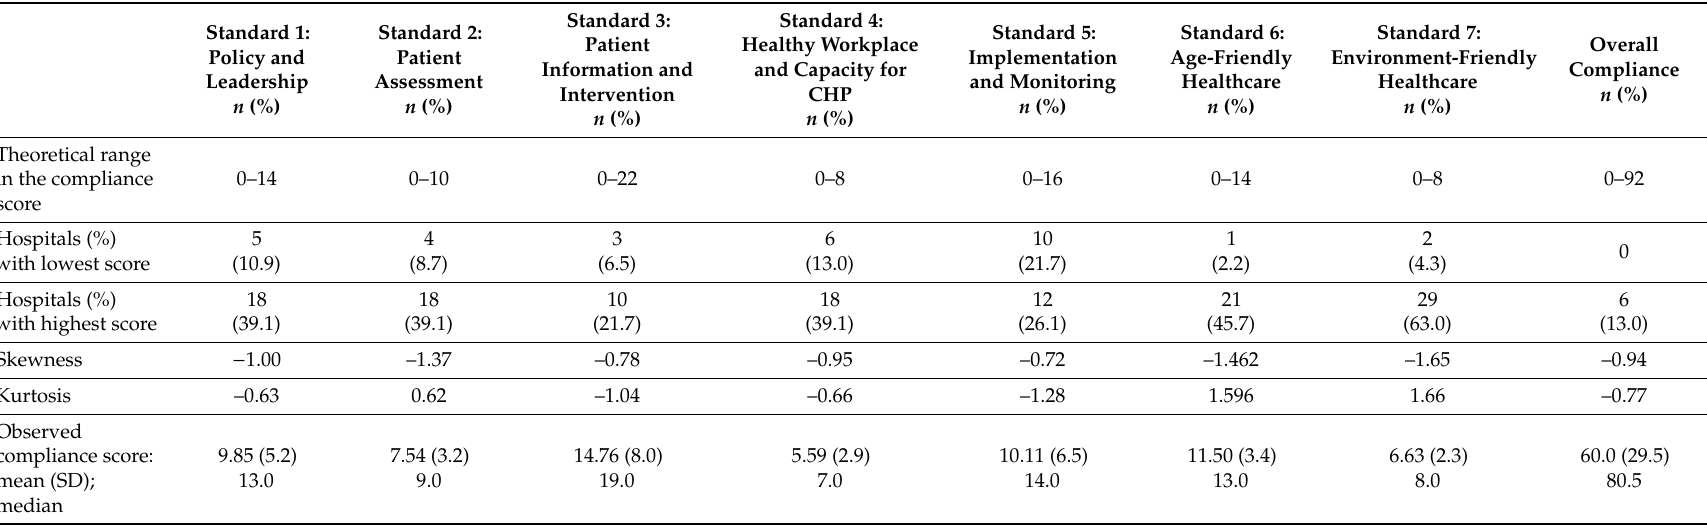
Table 4. Compliance with standards: distribution, floor, and ceiling e ff